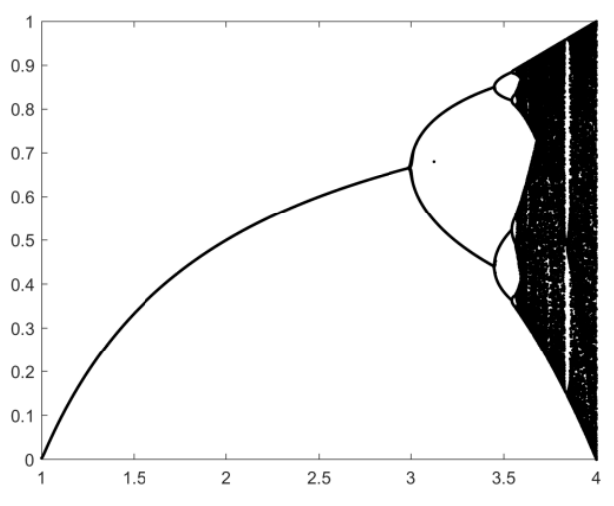
Figure 2. Sequence distribution under different bifurcation parameters.